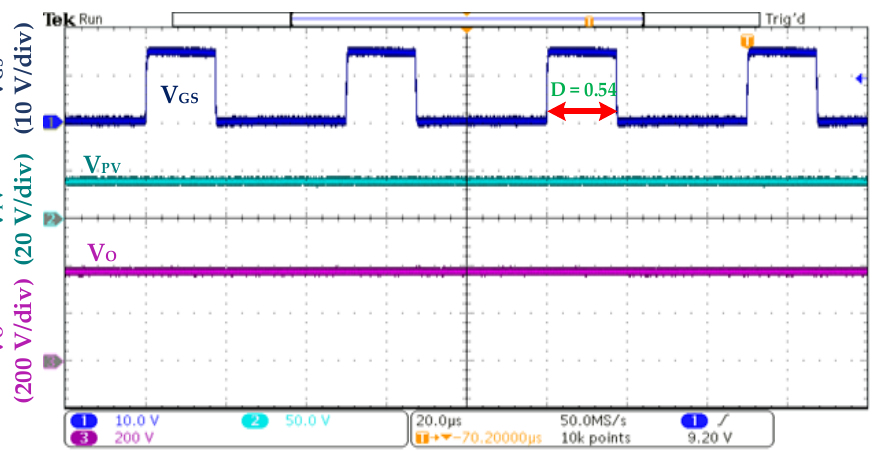
Figure 19. Experimental waveform for the gate source voltage (V GS ), solar photovoltaic simulator output voltage (V PV ), and output voltage (V o ) for the proposed HVGSU converter at the 0.39 duty cycle (Hor: 20 µs/div).